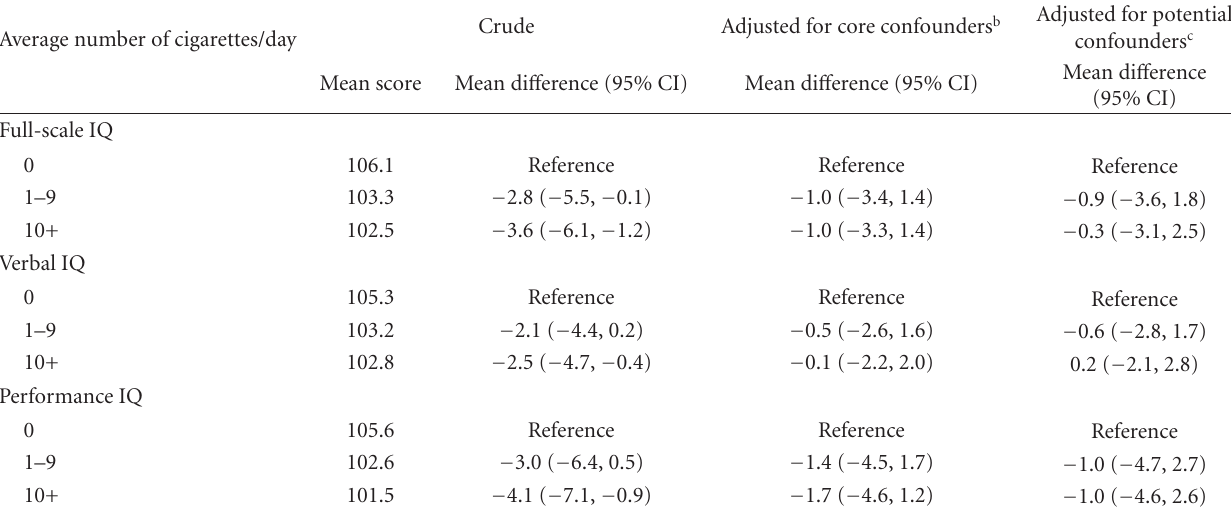
Table 2: Maternal smoking in pregnancy and WPPSI-R a performance.